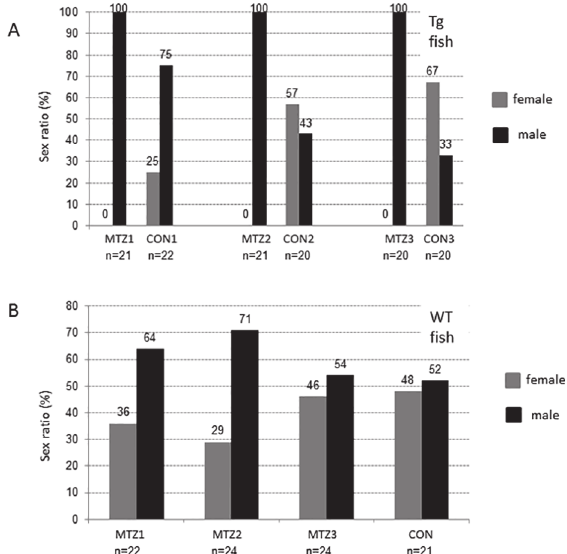
treatment for 25 days. The total numbers of fish were labeled under each group.